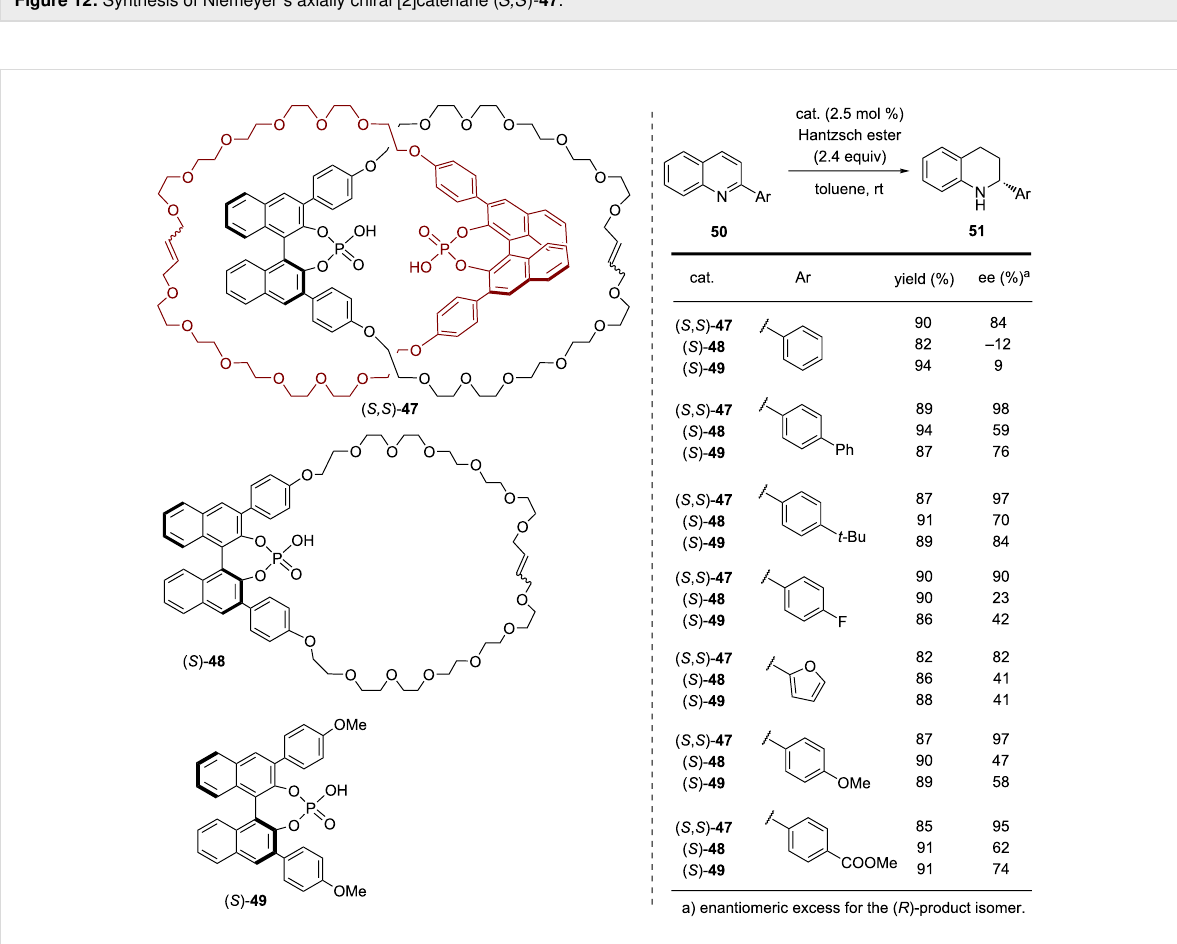
Figure 13: Results for the enantioselective transfer hydrogenation of 2-phenylquinoline with catalysts ( S,S )- 47 , (S)- 48 , and (S)- 49